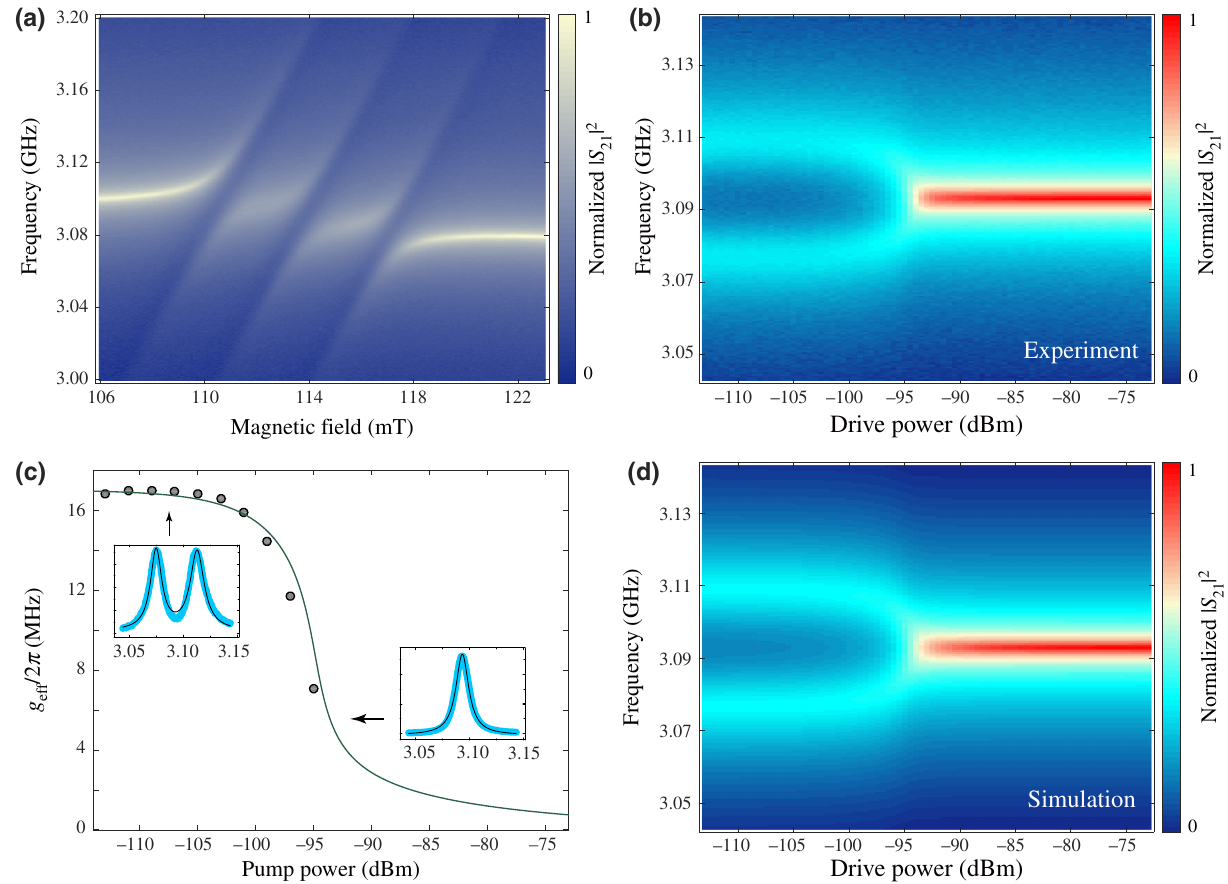
FIG. 2. The experimental realization of the exceptional point. (a) The transmission spectrum measured with a probe tone of power − 120 dBm, corresponding to an average photon number n = 404. (b) The Rabi splitting due to the coupling between the magnons of the s = 0 subensemble and the resonator photons versus the power of the drive tone. Here, the static magnetic field is tuned to have the magnons of the s = 0 subensemble in resonance with the resonator mode: ω 0 / 2 π = ω c / 2 π = 3.093 GHz. Note that the decay rate of the resonator is nearly independent of the power of the drive tone [cf. Fig. 8(b) in Appendix C]. (c) The effective magnon-photon coupling (gray circles) extracted from the Rabi splittings in (b). The fitting curve is obtained using Eq. (6), with parameters g / 2 π = 17.2 MHz, κ/ 2 π = 0.6 MHz, and γ/ 2 π = 11.9 MHz. (d) The transmission spectrum simulated with Eq. (1), where the fitting curve in (c) is used for the effective magnon-photon